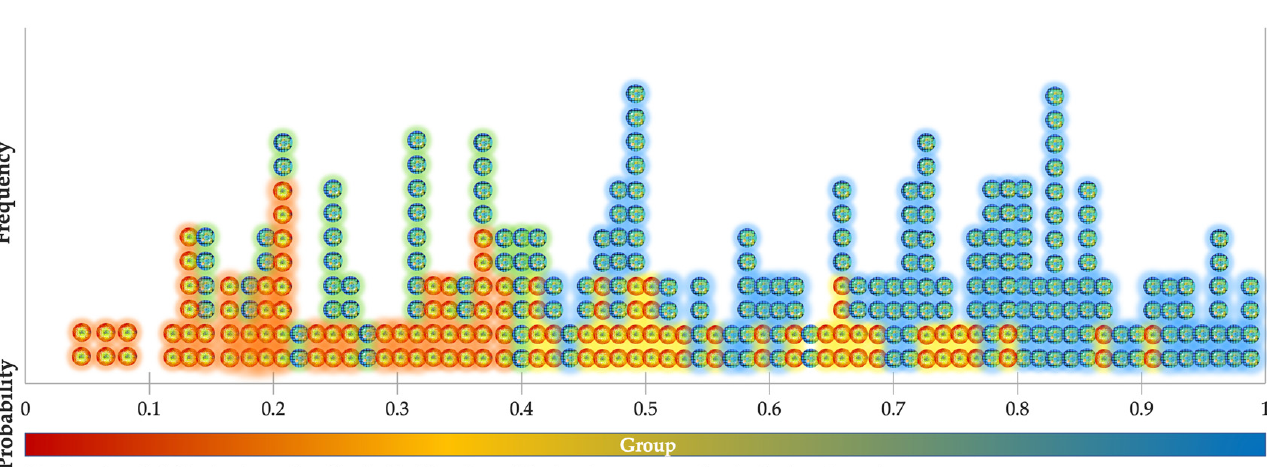
Figure 1. Observed groups (Logit) and predicted